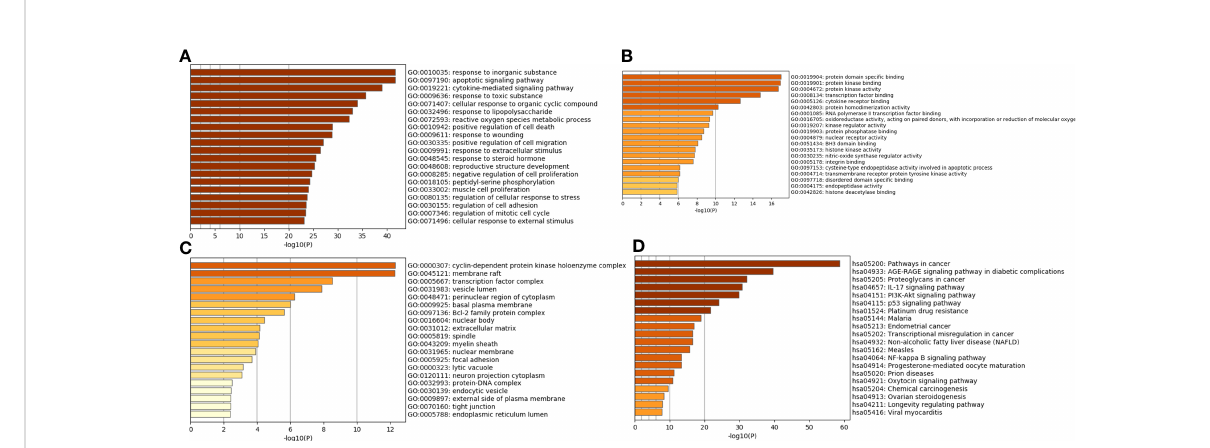
FIGURE 3 GO and KEGG enrichment analysis of the potential WJR targets for CRC treatment. GO enrichment analysis of the top 20 terms of (A) BP, (B) MF, and (C) CC. (D) The top 20 pathways of the KEGG enrichment analysis. BP, biological process; MF, molecular function; CC, cellular component. WJR, Wenzi Jiedu Recipe; CRC, colorectal cancer; BP, biological process; MF, molecular function; CC, cellular components.